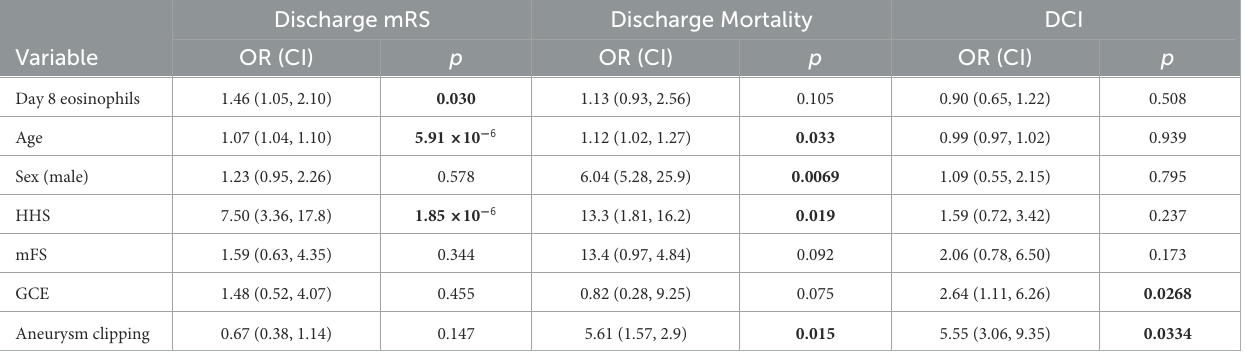
TABLE 2 Multivariable models for clinical outcomes based on day